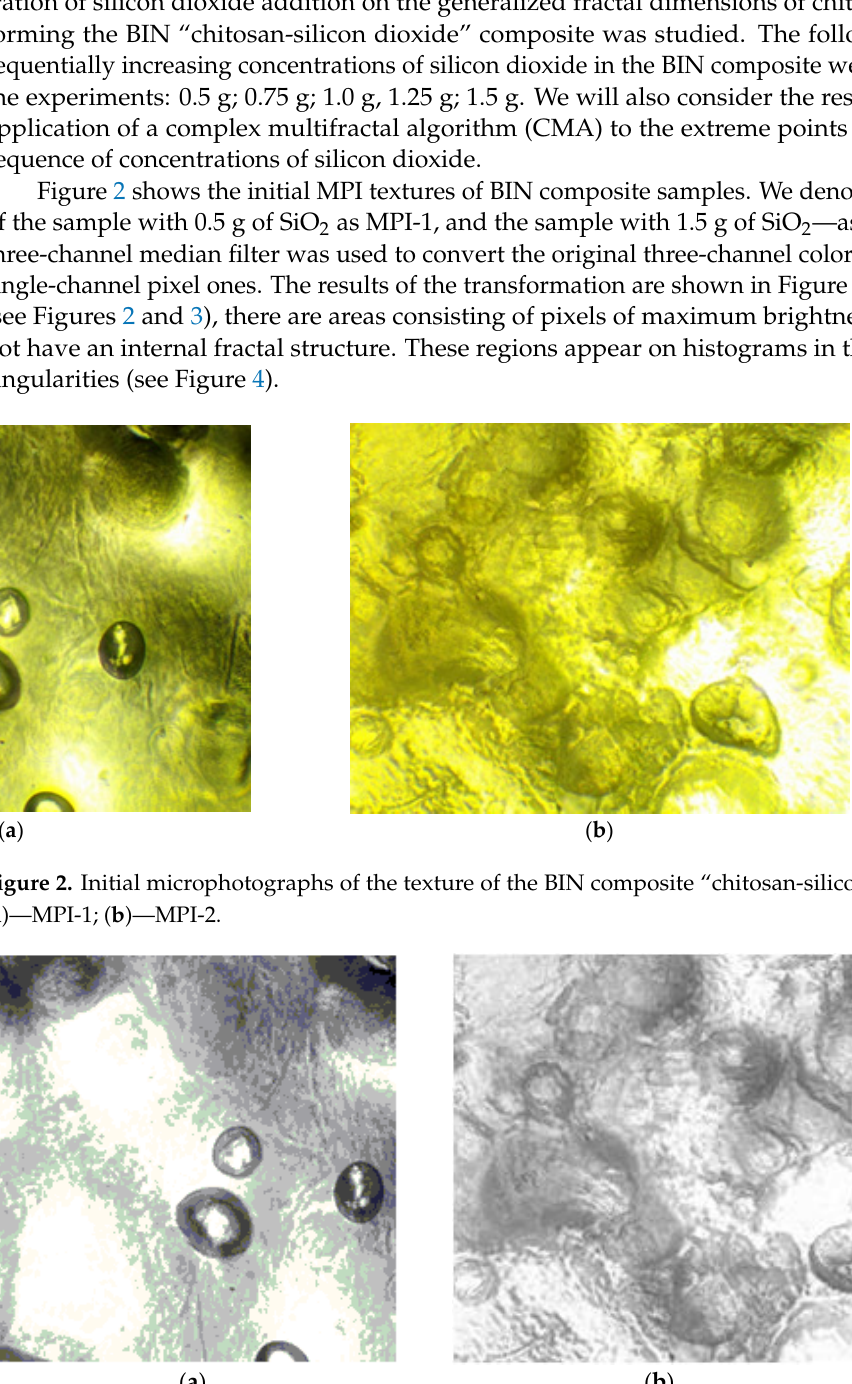
Figure 3. The results of the transformation by the median three-channel filter of the original color MPIs (Algorithm Step 1.1): ( a )—MPI-1; ( b )—MPI-2.